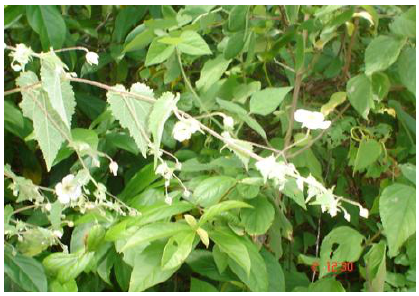
Figure 3. Herissantia crispa L.